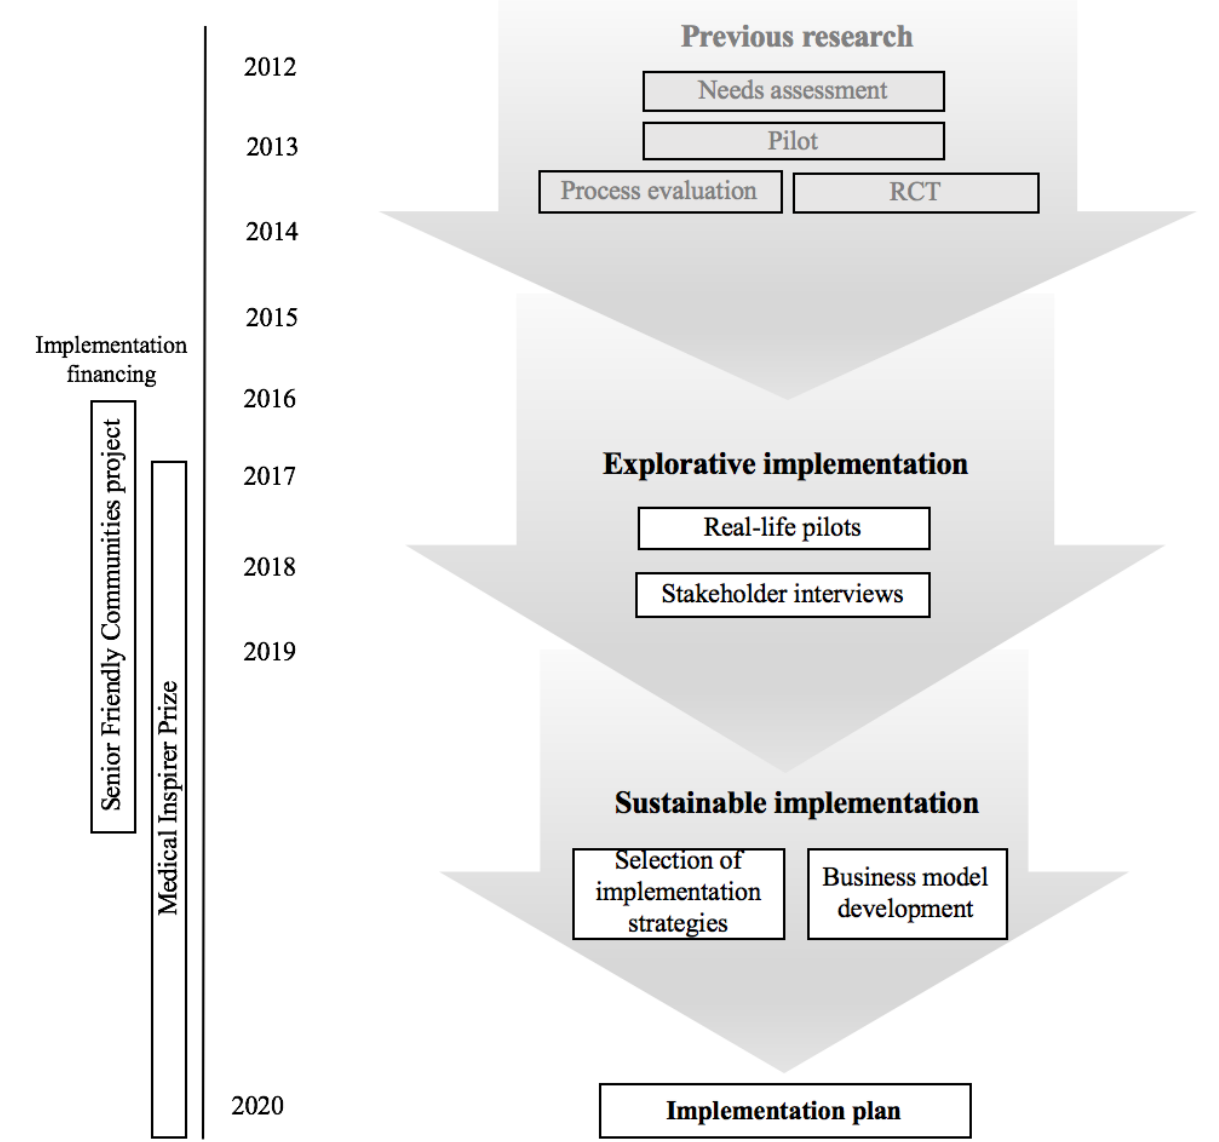
Figure 1. Partner in Balance development and implementation trajectory. RCT: randomized controlled